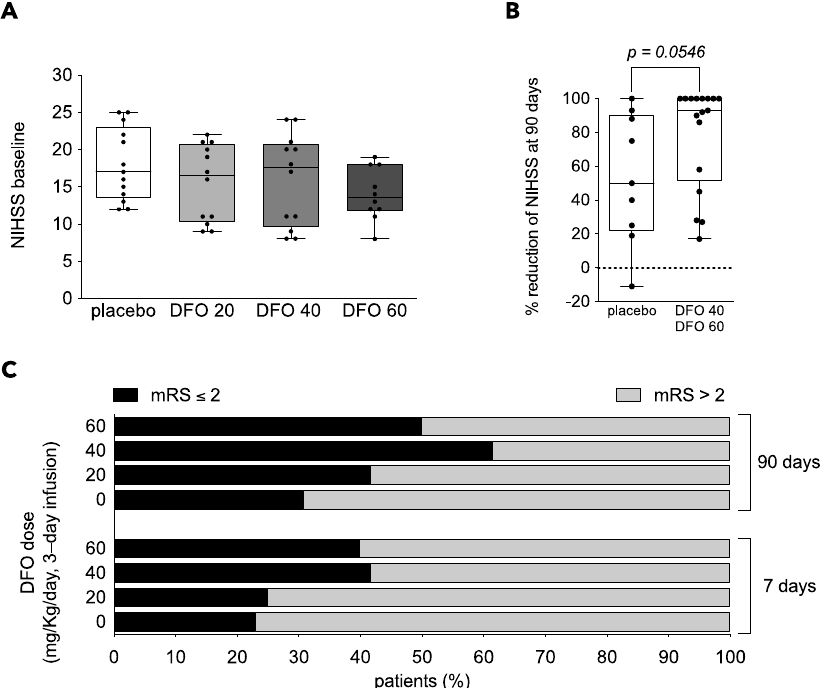
Figure 3. Exploratory analysis to examine whether the TSAT-modifier deferoxamine (DFO) doses favors a good outcome. ( A ) Median and quartiles of baseline NIHSS in a subpopulation of the TANDEM-1 study with NIHSS at admission > 7. Baseline NIHSS were found balanced between the four treatment groups when considering this patient subpopulation (NIHSS > 7) ( p = 0.24, one-way ANOVA). ( B ) In this subpopulation (NIHSS > 7) we calculated the percentage of neurological improvement with the formula: % reduction of NIHSS at 90 days = ((NIHSS at admission-NIHSS at a given time)*100/NIHSS at admission). As DFO 40 and DFO 60, but not DFO 20, reduce TSAT, these two groups were pooled and compared to the placebo group. We observed that half of the patients in the 40 + 60 DFO group showed a 100% reduction of their initial neurological impairment, in contrast to those in the placebo group ( p = 0.0546, Mann–Whitney U test). ( C ) Graph depicting the proportion of AIS patients showing good functional outcome (in black) in the placebo and DFO groups. DFO dose tiers of 40 and 60 mg/Kg/day have higher proportion of AIS classified as good outcome patients (mRS ≤ 2) at 7 and 90 days. Values are presented as median and quartiles and compared with one-way ANOVA ( A ) or Mann–Whitney U test ( B ).